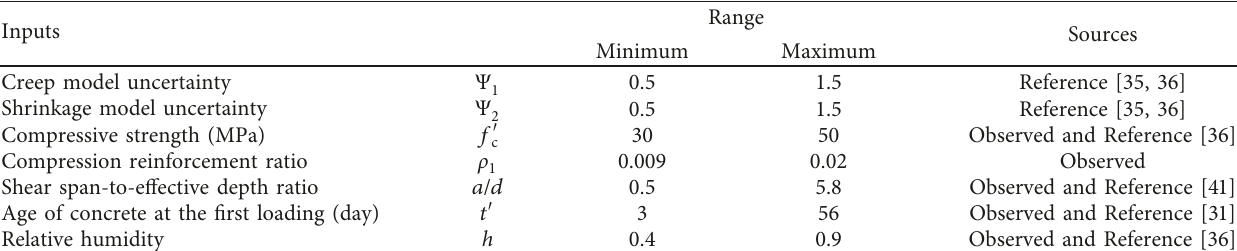
Table 4: Boundary range of input